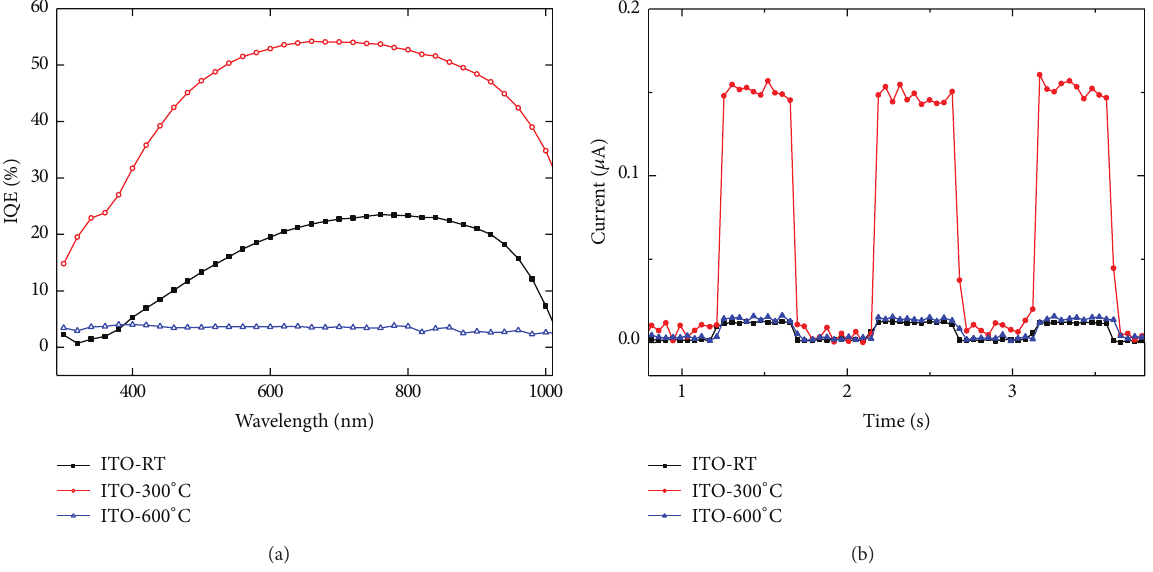
Figure 15: (a) IQE profile and (b) photoresponses at wavelength of 350 nm of ITO-RT, ITO-300 ∘ C, and ITO-600 ∘ C samples [4].